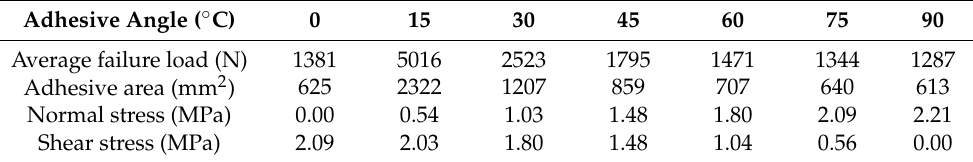
Table 10. Failure strength values of seven groups of adhesive specimens at different angles at 80 ◦